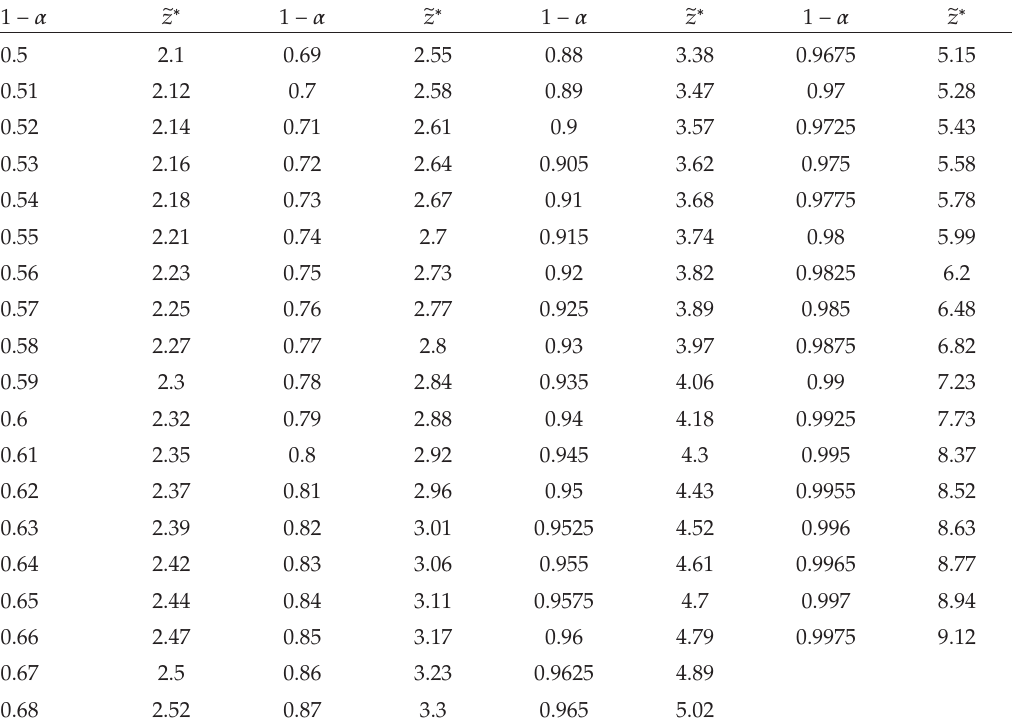
(cid:20) Z ∗ of Figure 4, where n (cid:4) 10 5 . The column 1 − α gives the probabilities, and the n (cid:20) Z ∗ n